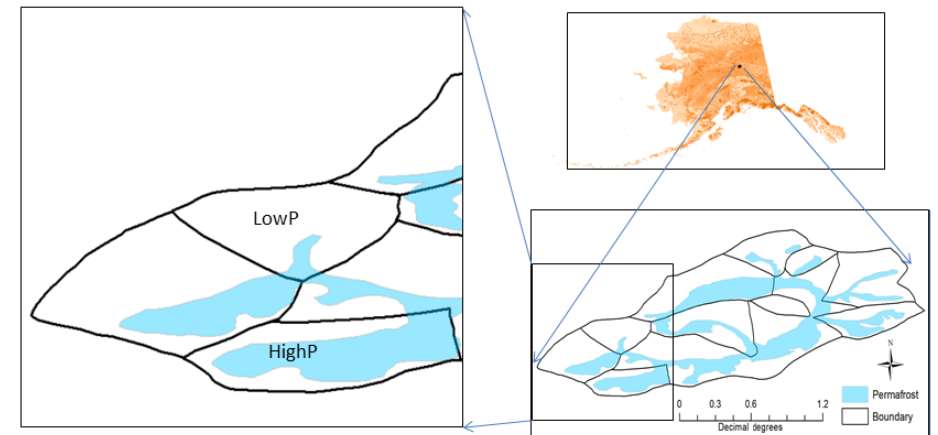
Figure 1. Location and permafrost extent (light blue shading) in the Caribou Poker Creek Research Watershed, Alaska, and the two sub- basins of interest (low permafrost or LowP sub-basin and high permafrost or HighP sub-basin). The permafrost map of CPCRW was produced by a small-scale observation across the watershed (Rieger et al., 1972; Yoshikawa et al.,